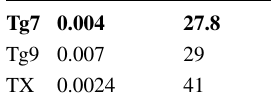
Fig. 1 ST (mN/m) versus CMC (% v/v) of single NIS Table 3 ST (mN/m)